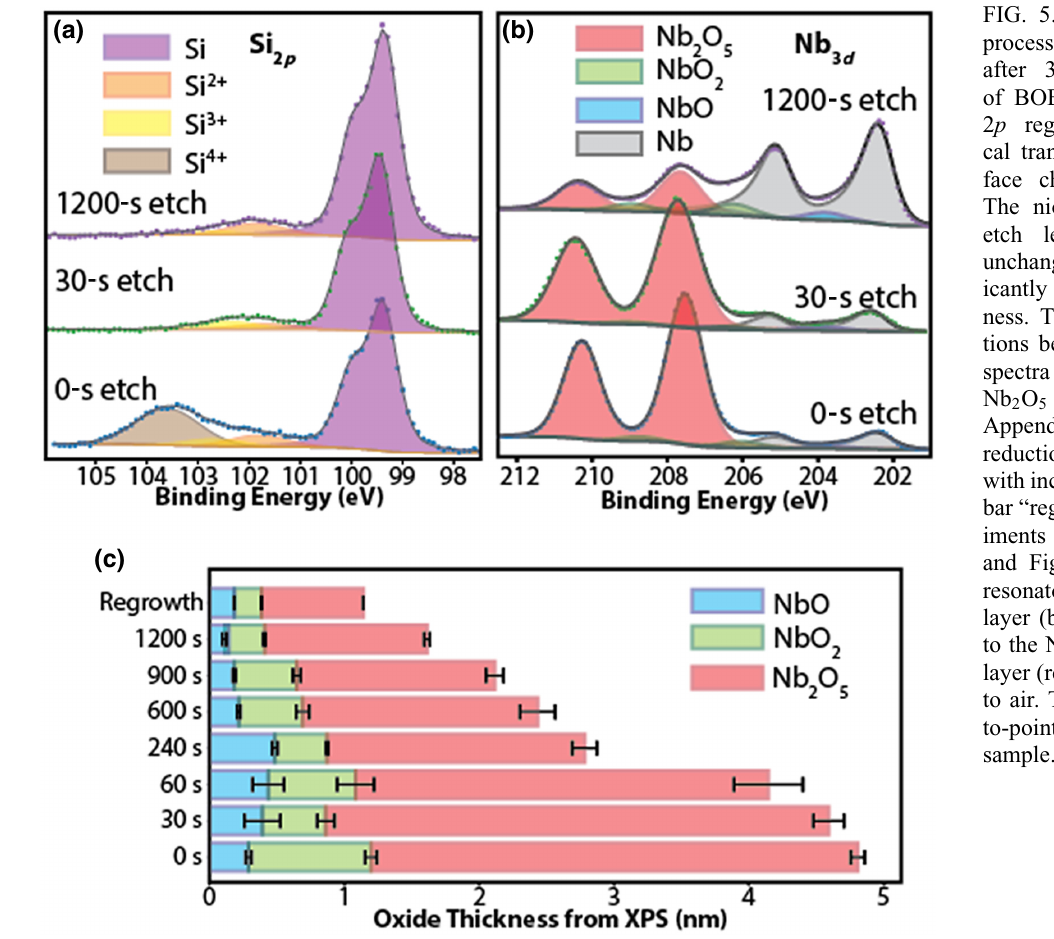
FIG. 5. XPS measurements of process oxides before etching, after 30 s, and after 1200 s of BOE etching. (a) The silicon 2 p region showing the chemi- cal transformation of SiO x inter- face chemistry by etching. (b) The niobium 3 d region. A 30 s